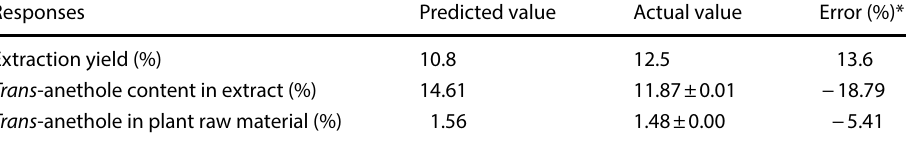
Table 3 Predicted values, actual values, and percent error of the